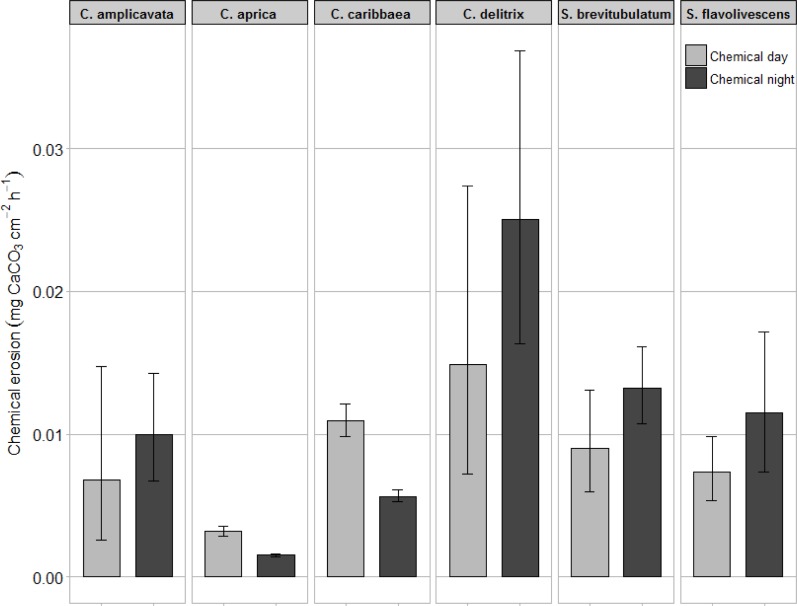
Chemical bioerosion.Hourly rates of chemical dissolution (mg CaCO3 cm-2 d-1) are given for the six studied sponge species (top). Both day (light grey) and night (dark grey) erosion rates are included. Rates are derived from alkalinity change in flow-through incubation. Error bars indicate the 95% confidence limits.